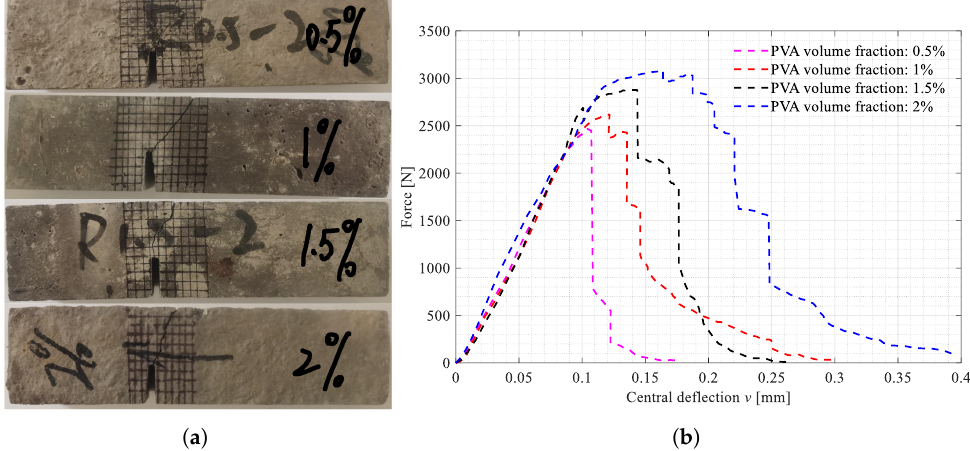
Figure 8. The broken beam specimens with C l = 20 mm and the central deflection-force diagrams.